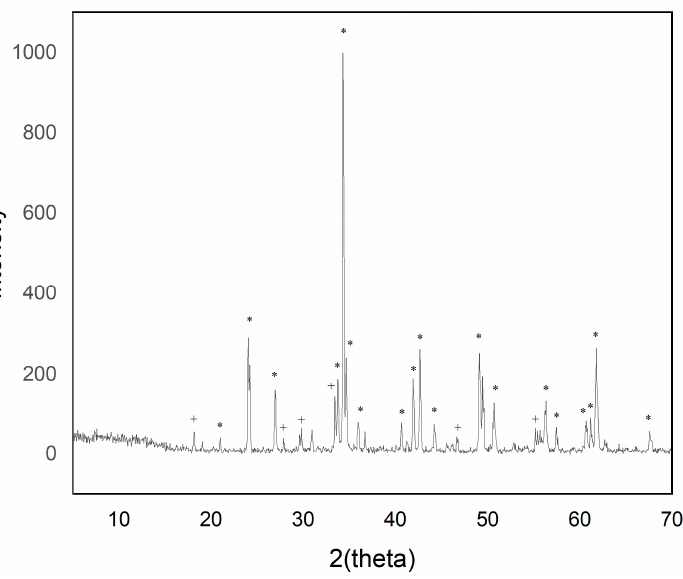
Figure 2. XRD of sample Y 0.99 AlCr 0.01 O 3 1500 °C/6 h with 5% w / w CaF 2 addition (+ garnet Y 3 Al 5 O 12 phase; * perovskite YAlO 3 phase).